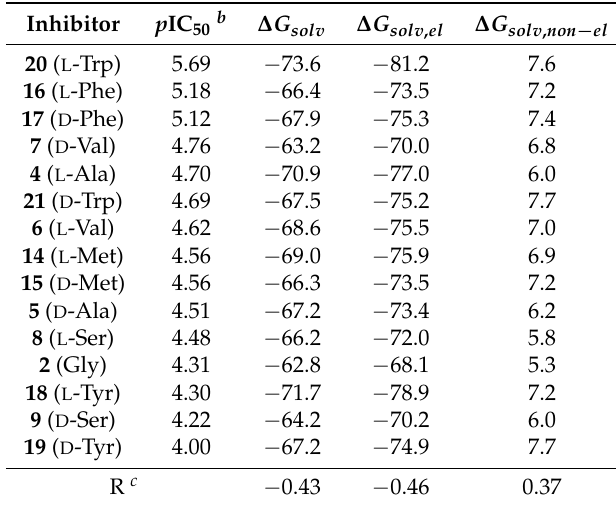
Table 3. Solvation free energy ( ∆ G solv ) of inhibitors of EphA2-ephrin A1 interaction with its electrostatic, ∆ G solv , el , and non-electrostatic,